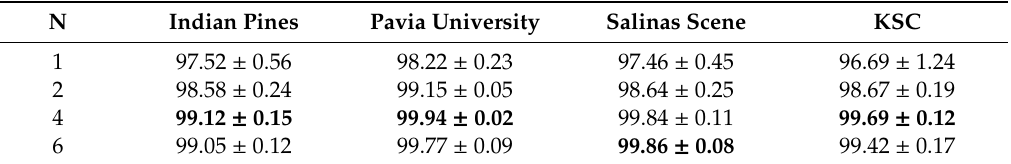
Table 3. The overall accuracy (%) obtained by the MSSN with di ff erent numbers of 3D–2D residual connections. Data are given as mean ± standard